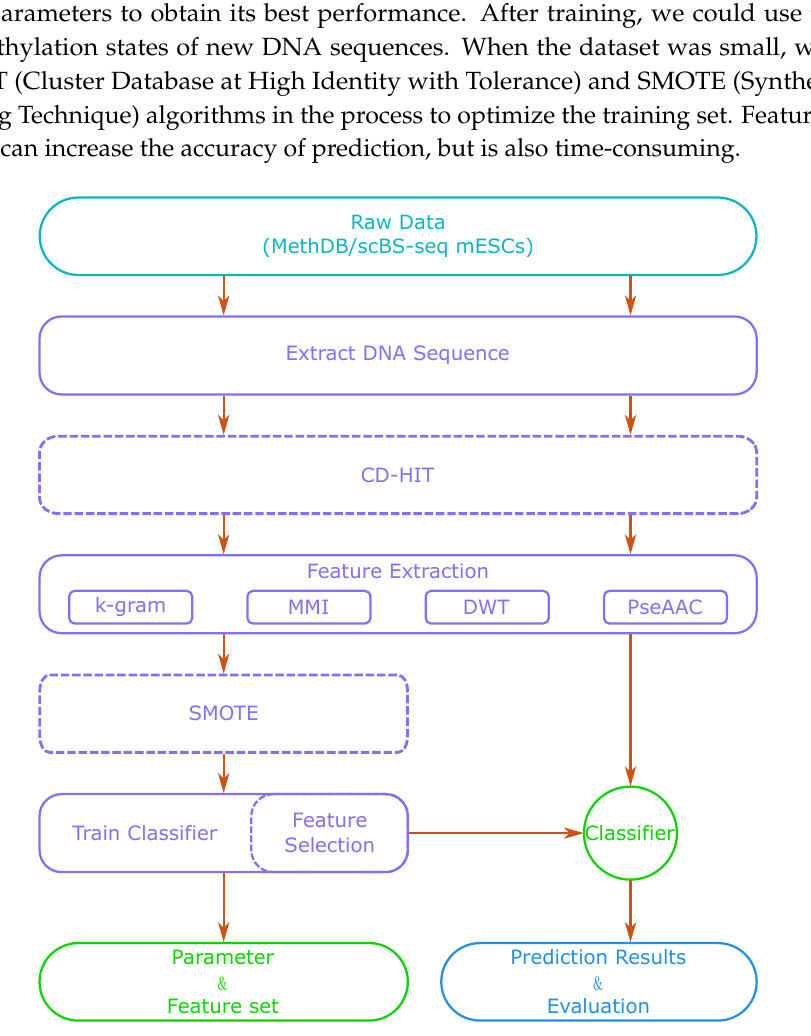
Figure 1. The flow chart of our method. DWT: discrete wavelet transform; mESC: mouse embryonic stem cell; MMI: multivariate mutual information; PseAAC: pseudo amino acid composition; CD-HIT: Cluster Database at High Identity with Tolerance; SMOTE: Synthetic Minority Over-sampling